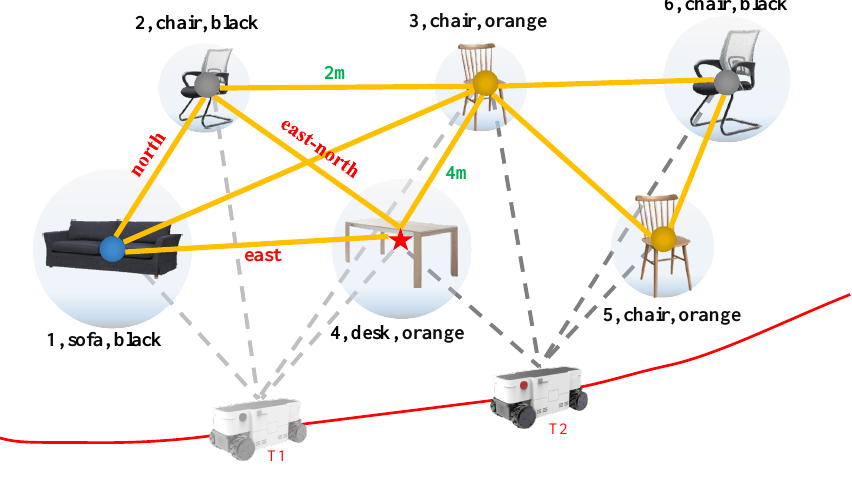
Figure 4. Illustration of our proposed agent-centric object-level topological semantic